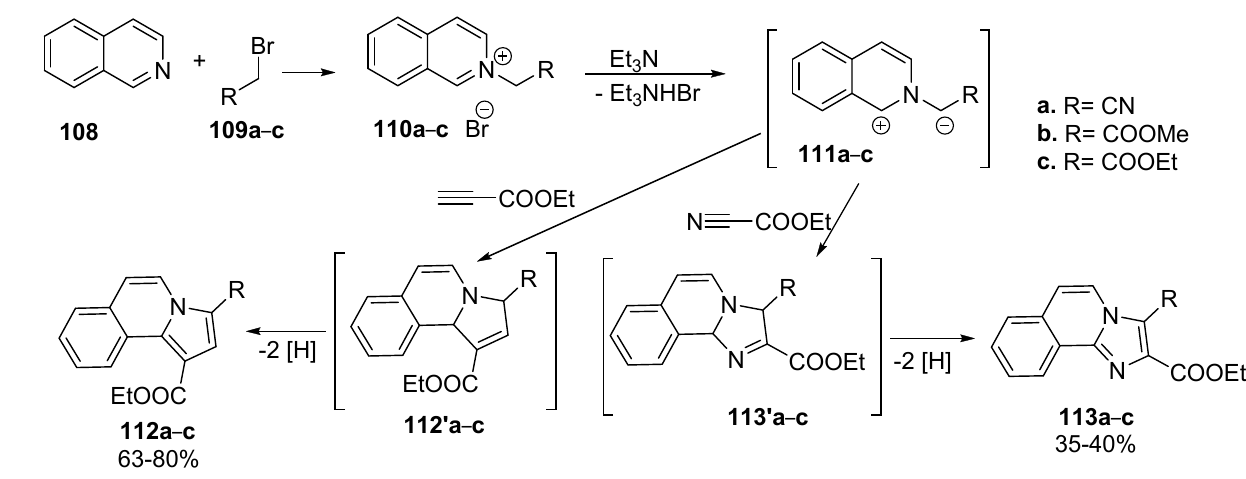
Table 19. Photophysical properties of isoquinoline